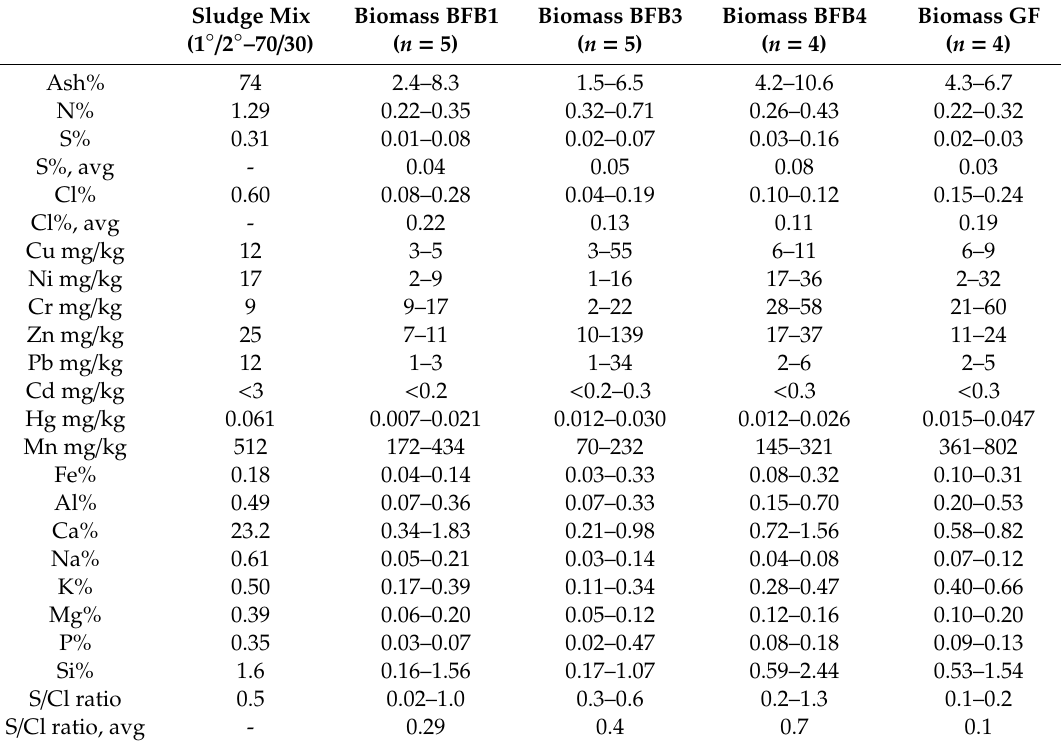
Table 4. Chemical composition of biomass (min–max) and sludge, in dry